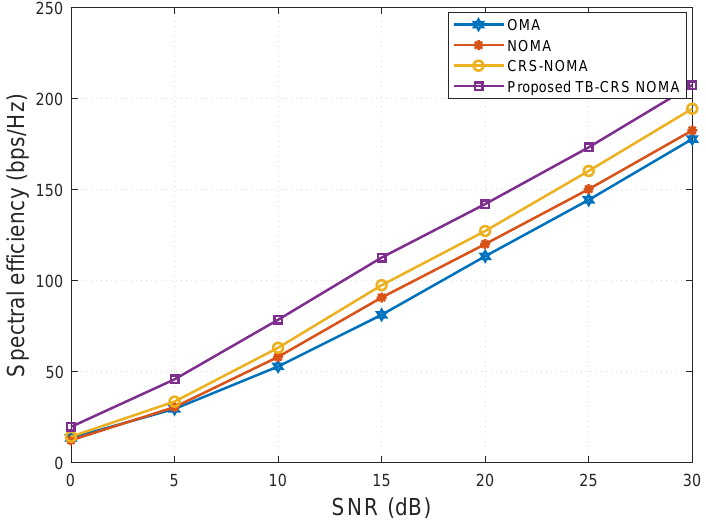
Figure 6. Spectral efficiency versus SNR for K = 32